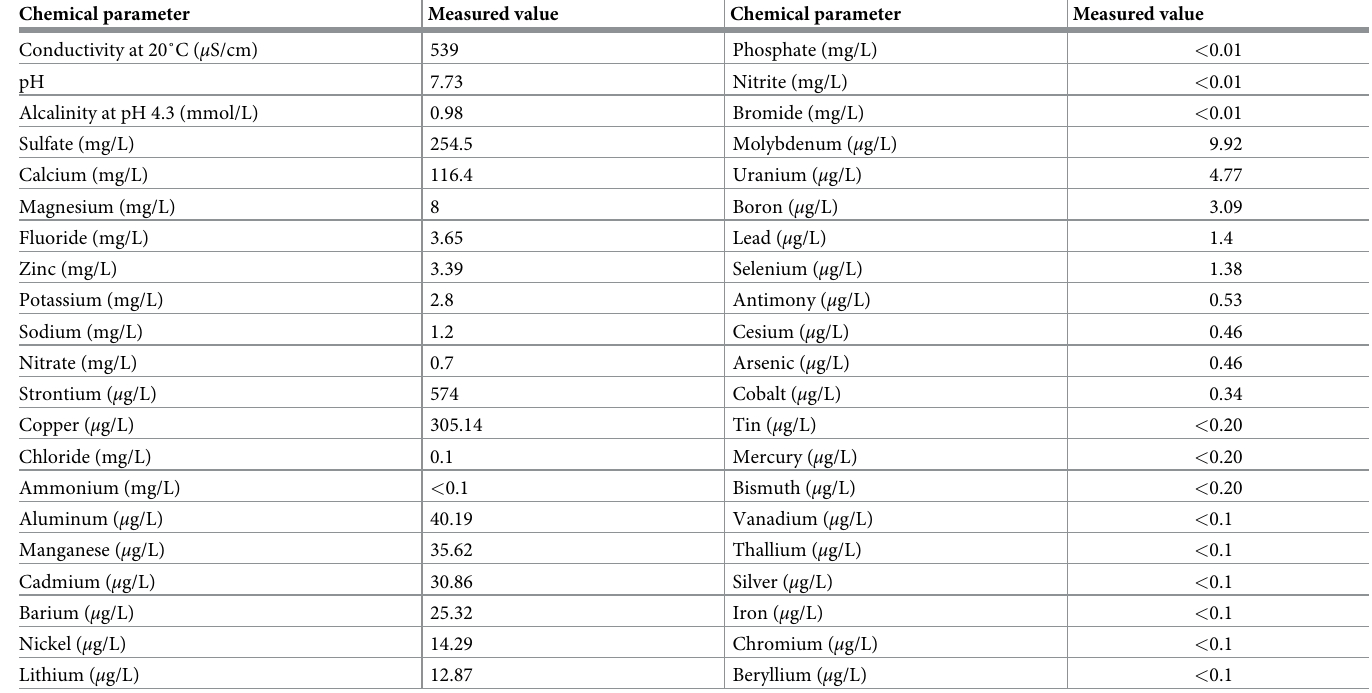
Table 1. Chemical analysis of the spring